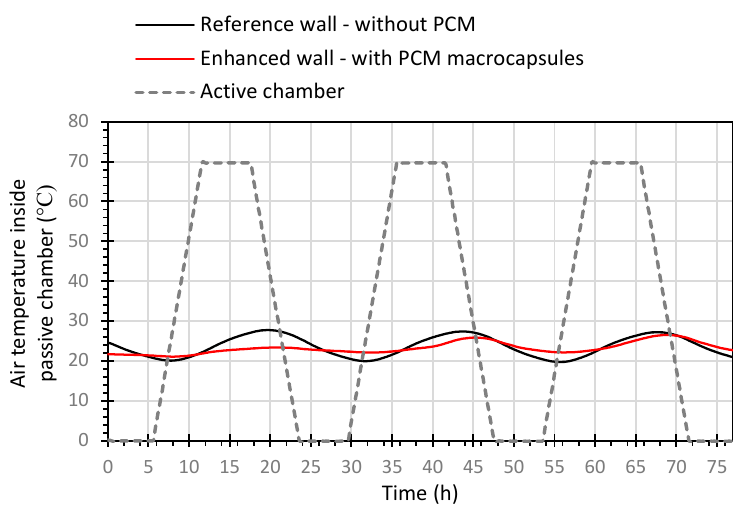
Figure 12. Hot box results: indoor air temperature profiles.